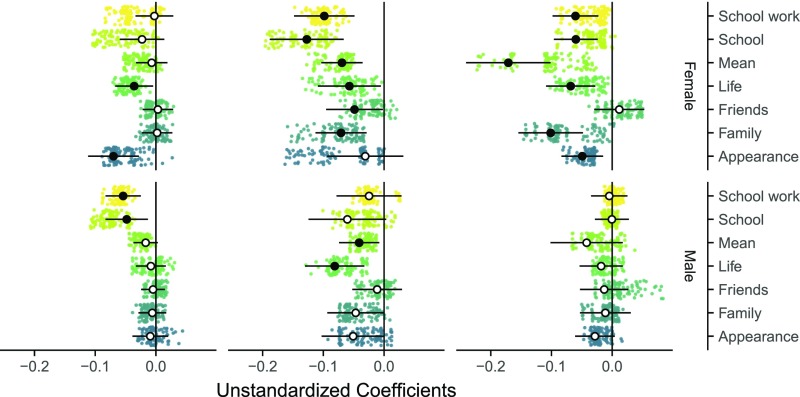
Relation between life satisfaction and social media use in female (Upper) and male (Lower) adolescents. (Left) Between-person correlations. (Center) Within-person effects of social media use on life satisfaction. (Right) Within-person effects of life satisfaction on social media use. Small dots represent results of each possible combination of theoretically defensible analytical decisions. Large circles represent results of the best practice models (white indicates P > 0.05, black indicates P < 0.05).